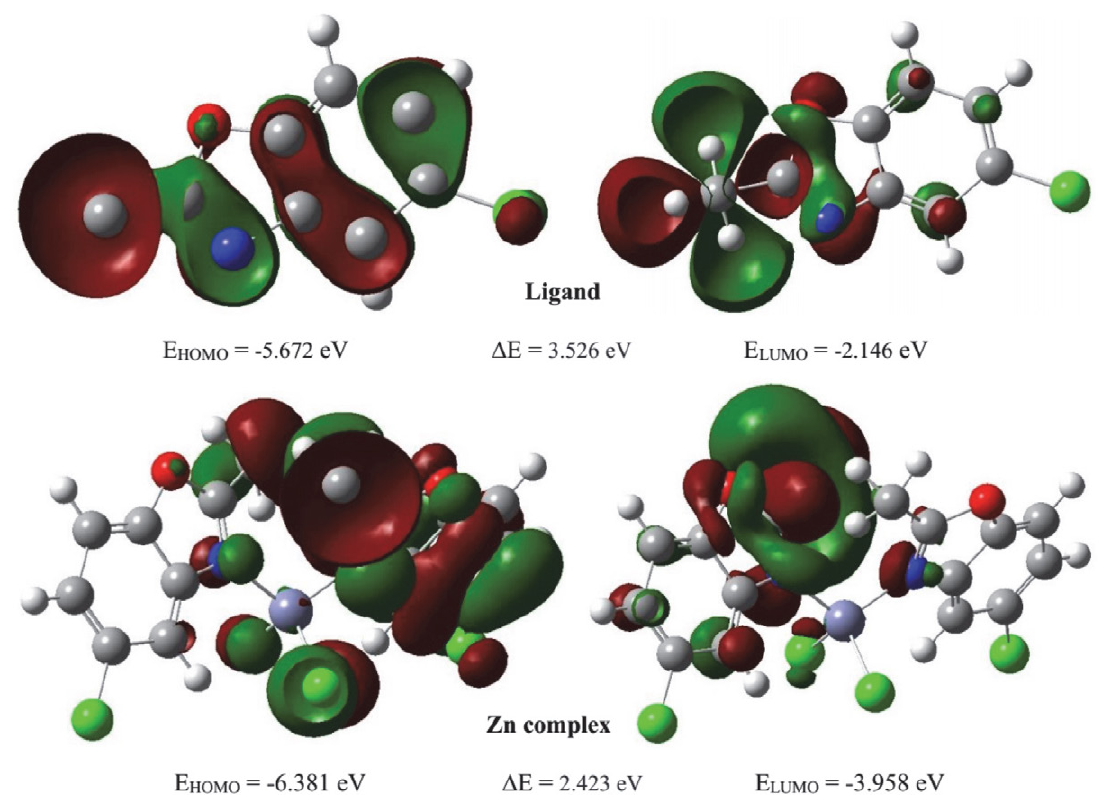
Figure 3. Surface plots of HOMO and LUMO orbitals of ligand (L) and zinc